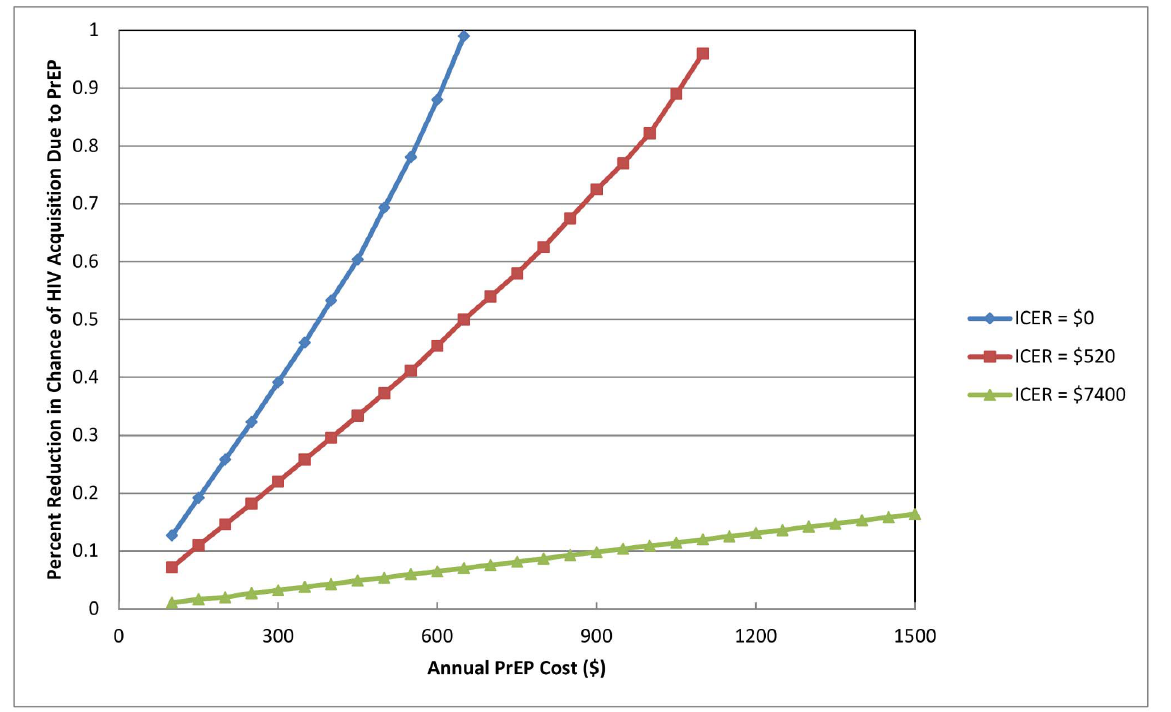
Figure 4. Breakeven effectiveness for PrEP as a function of its annual cost. Effectiveness is measured as percentage reduction in chance of HIV infection acquisition. Assumes 25% of uninfected IDUs are enrolled in PrEP, in comparison to the status quo (no scale up of MMT or ART). Bottom line (triangles) shows minimum effectiveness for which PrEP would be considered highly cost effective (ICER= $ 7,400). Middle line (diamonds) shows minimum effectiveness for which PrEP would be as cost effective as MMT (ICER= $ 520). Top line (squares) shows minimum effectiveness for which PrEP would be cost saving (ICER= $ 0). PrEP=oral pre-exposure prophylaxis for injection drug users; ART=antiretroviral therapy; MMT=methadone maintenance therapy; ICER=incremental cost-effectiveness